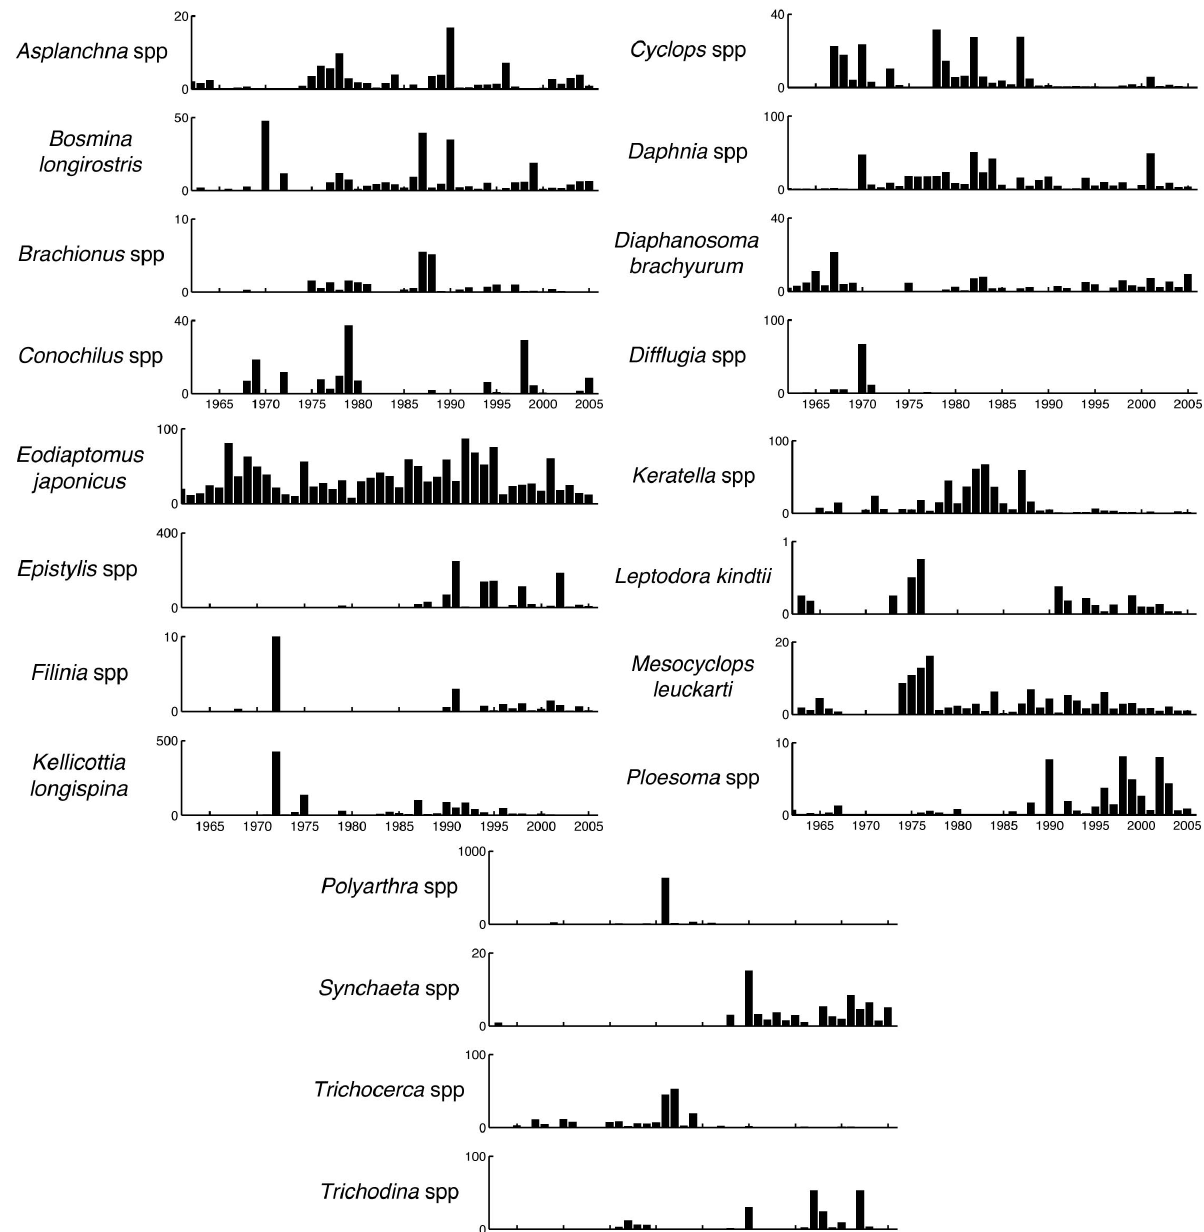
Fig. 2. Abundance (10 4 ind.m − 2 ) time series of dominant taxa. Dominant taxa are defined as taxa with occurrence ≥ 15yr among the 44 sampling